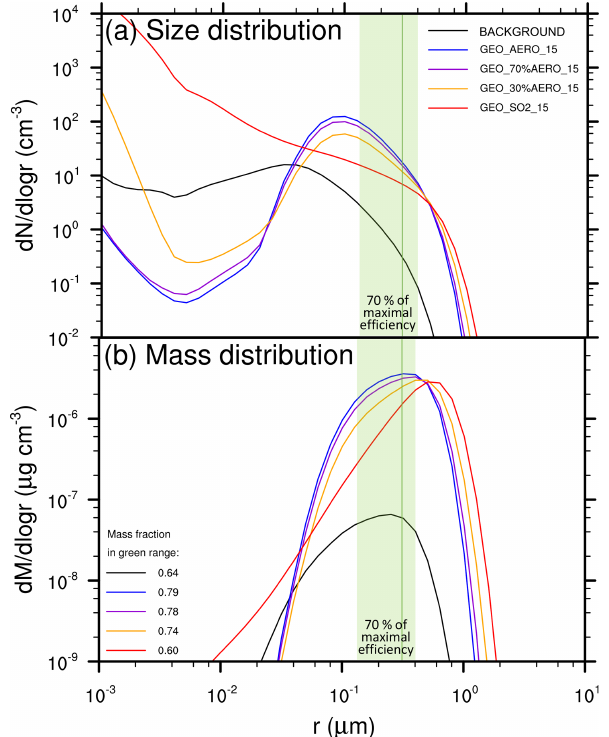
Figure 5. (a) Wet aerosol size distribution of scenarios with various emission mixtures of AM H 2 SO 4 and SO 2 averaged between 15 ◦ N and 15 ◦ S at 50hPa. The green size range is defined as the radius at which backscattering efficiency on sulfate aerosols is larger than 70% (i.e., 0.12–0.40µm) of its maximal value (solid green line at 0.30µm) following Dykema et al. (2016). (b) Mass distributions of the size distributions resulting from (a) including the wet aerosol mass fraction in the optimal size range between 0.12 and 0.40µm in the